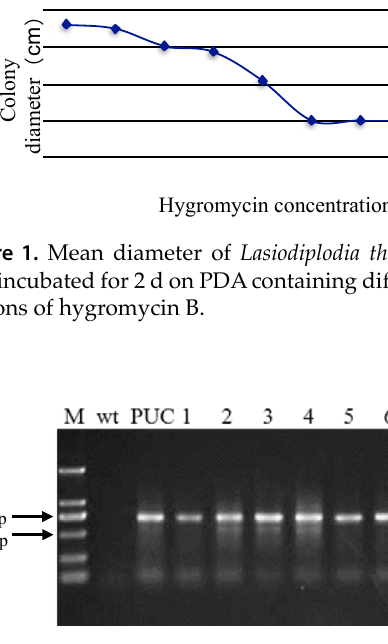
Figure 2. Identification of Lasiodiplodia theobromae transfor- mants through PCR using specific primers for hygromycin B. Legend: M, 2,000-bp marker (Takara); Wt, wild-type JZB 0300251 strain; PUC, pUCATPH plasmid; 1-9, randomly selected transformants.